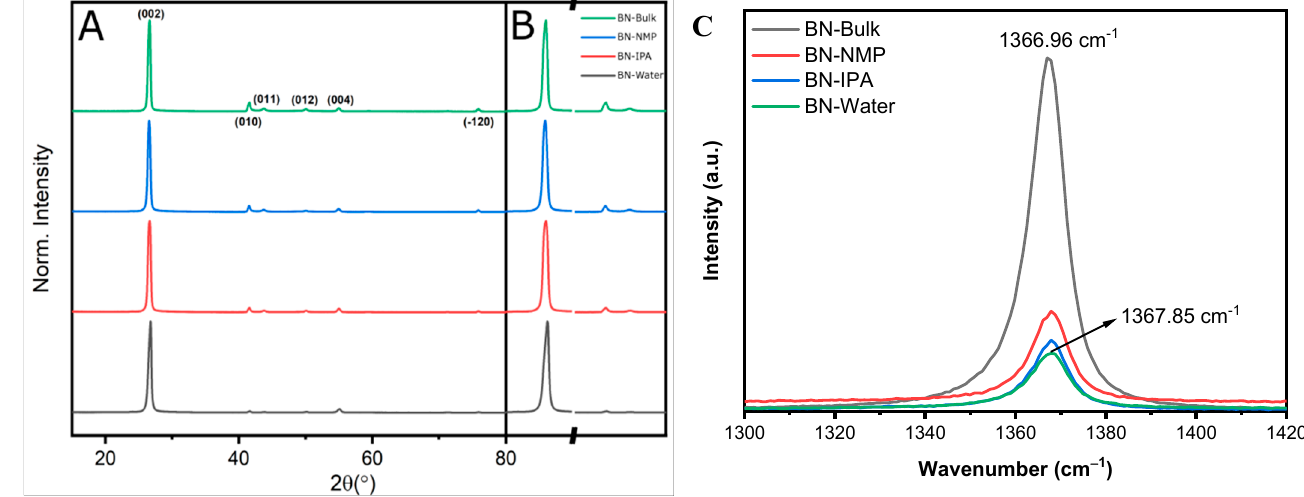
Figure 4. ( A ) Normalised PXRD patterns of bulk BN and exfoliated BN-NMP, BN-IPA and BN-Water. Miller indices are shown for the bulk material. ( B ) Comparison of (002), (010) and (011). ( C ) Raman spectra of h-BN in bulk form (black) and exfoliated BN-NMP (red), BN-IPA (blue) and BN-Water (green).